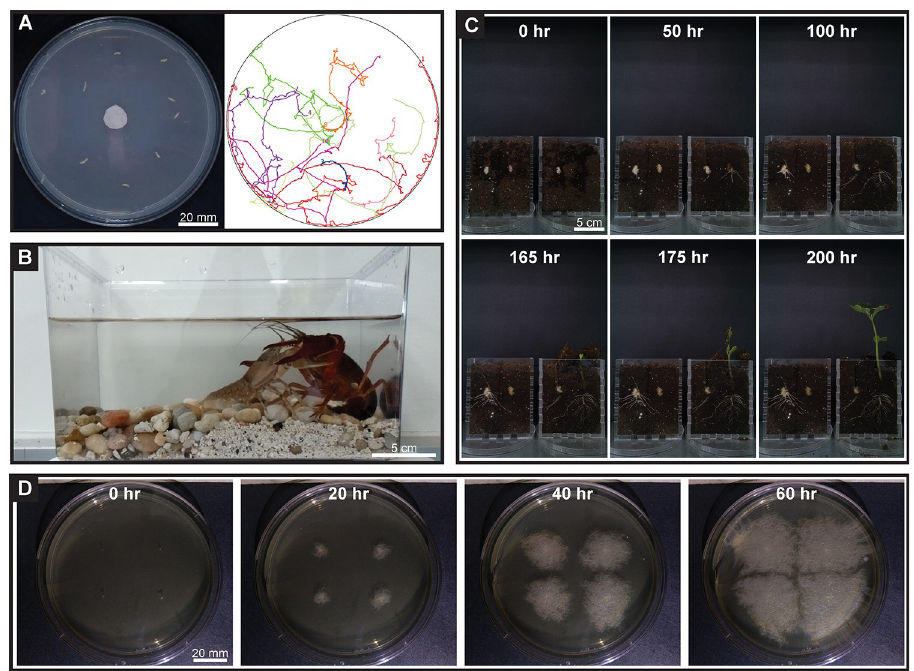
Fig 2. Video and time lapse image recording. A. Image of 10 D . melanogaster larvae initial position (left) and tracking data, with the number denoting that larva’s final position relative to central apple cider vinegar bait (right) (S1 Video). B. Image still of recording of crayfish dueling behavior. Two crayfish, one Orconectes rusticus and one Procambarus clarkii were placed in a container and PiSpy was used to record their interaction for thirty seconds (S2 Video). C. Representative images from a time lapse video of Phaseolus vulgaris bean growing in clear planters and imaged by PiSpy every 5 minutes (S3 Video). D. Representative images from a time lapse video (S4 Video) of Bacillus mycoides bacteria growing on a TSA+G agar plate and imaged by PiSpy every 5 minutes (S4 Video).